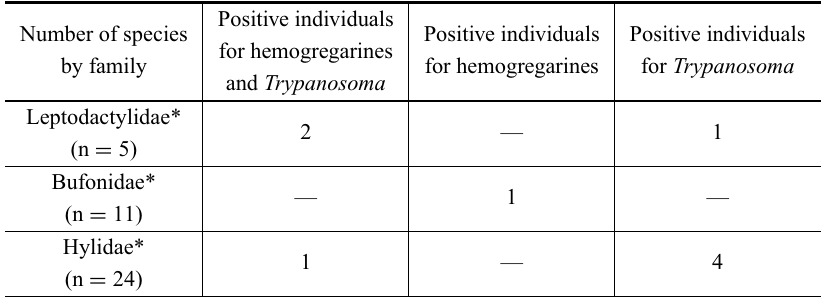
Fig. 1 – Hemogregarines and Trypanosoma spp. present in anurans captured in São Paulo and Mato Grosso do Sul States – Brazil.